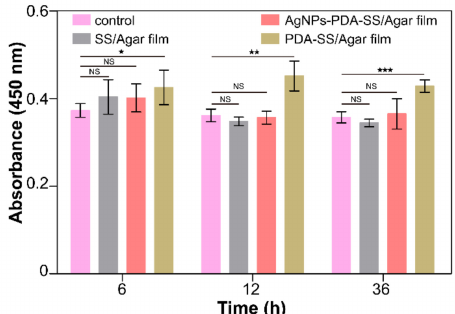
Figure 9. CCK-8 assay of the cytocompatibility of different films on NIH/3T3 cells. The statically significant values are expressed by “NS” (not significant), “ (cid:70) ” ( p < 0.05), “ (cid:70)(cid:70) ” ( p < 0.01) and “ (cid:70)(cid:70)(cid:70) ” ( p <